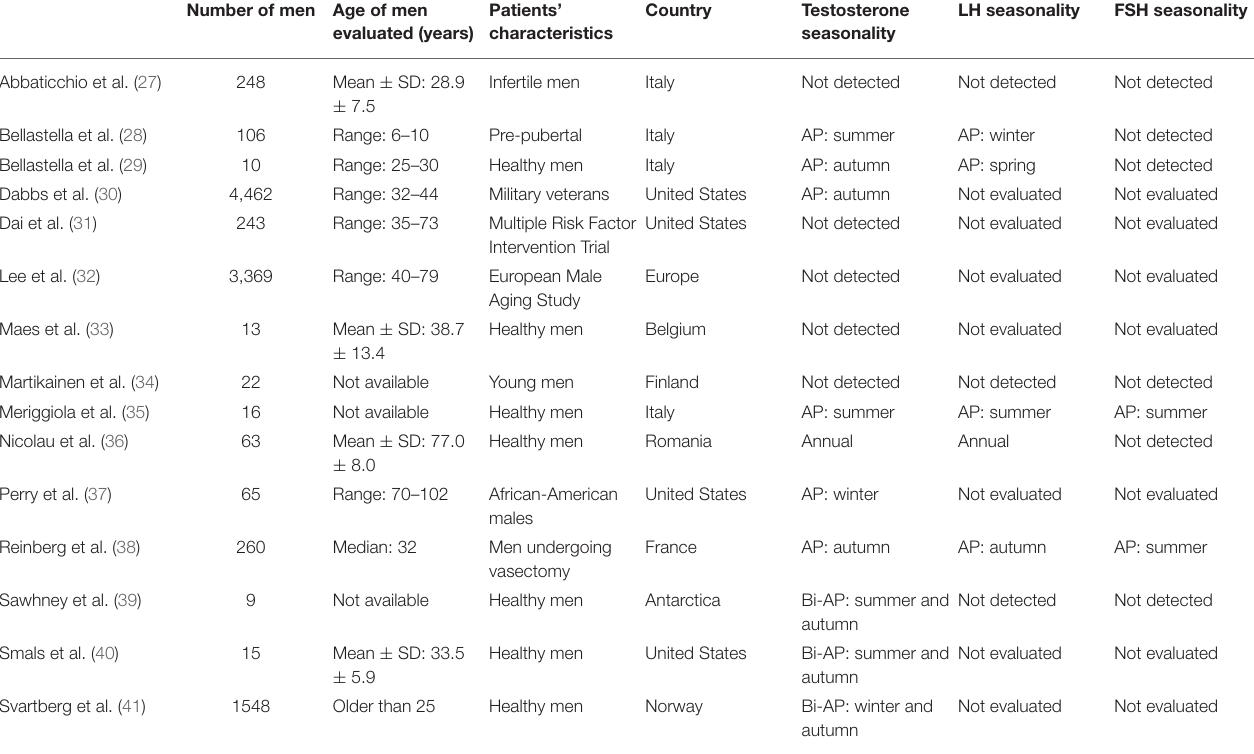
TABLE 3 | Published trials on testosterone seasonality. Number of men Age of men Patients’ evaluated (years)